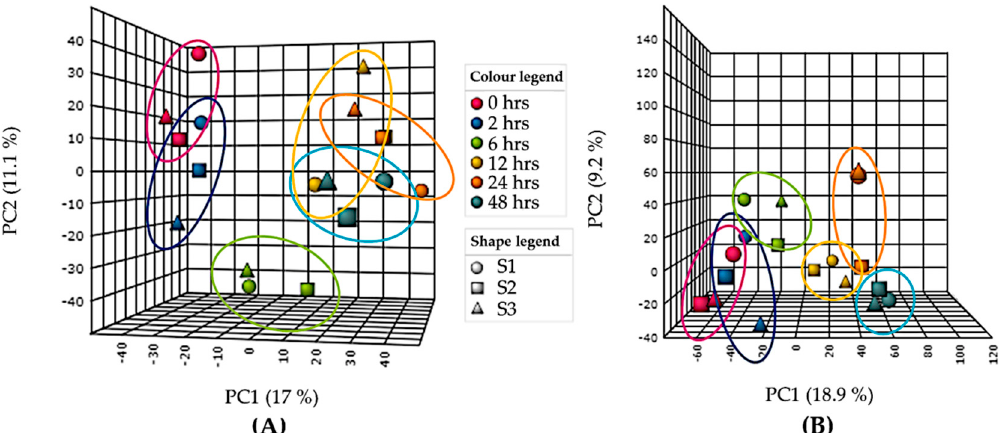
Figure 1. Principle component analysis (PCA) of ( A ) intracellular and ( B ) extracellular gas chromatography-mass spectrometry (GC–MS) data of UV-B exposed (PAR + UV-B) Chlorogloeopsis fritschii ( C. fritschii ) cultures showing PC1 vs PC2 only. Each ring represents distribution of biological replicates. S1 = replicate 1, S2 = replicate 2, S3 = replicate 3.